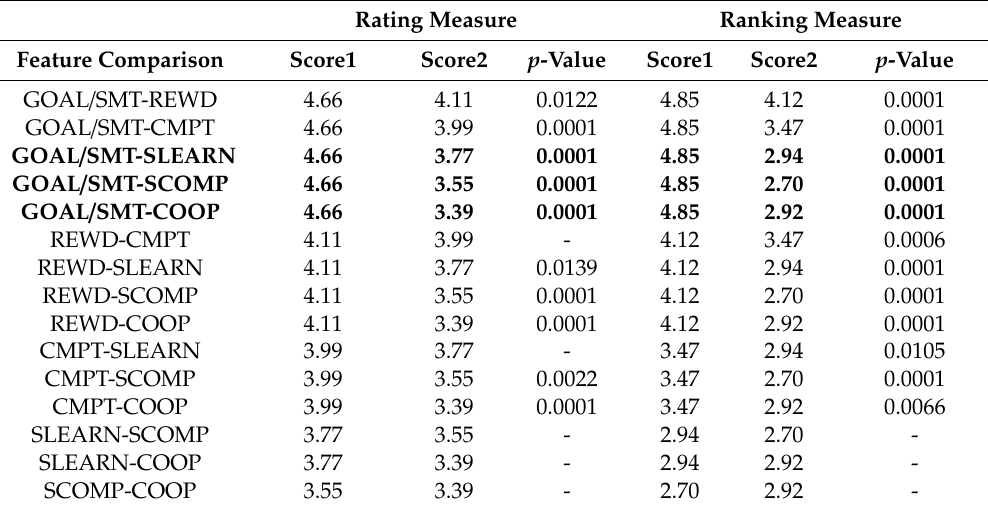
Table 6. Posthoc pairwise comparisons of persuasive features for the individualist population sample. “-” means there is no significant di ff erence between each pair of features; bold values indicate the result of pairwise comparison is in the same direction regardless of measure and culture; REWD = Reward, GOAL / SMT = Goal-Setting / Self-Monitoring, CMPT = Competition, SCOMP = Social Comparison, SLEARN = Social Learning, COOP = Cooperation.